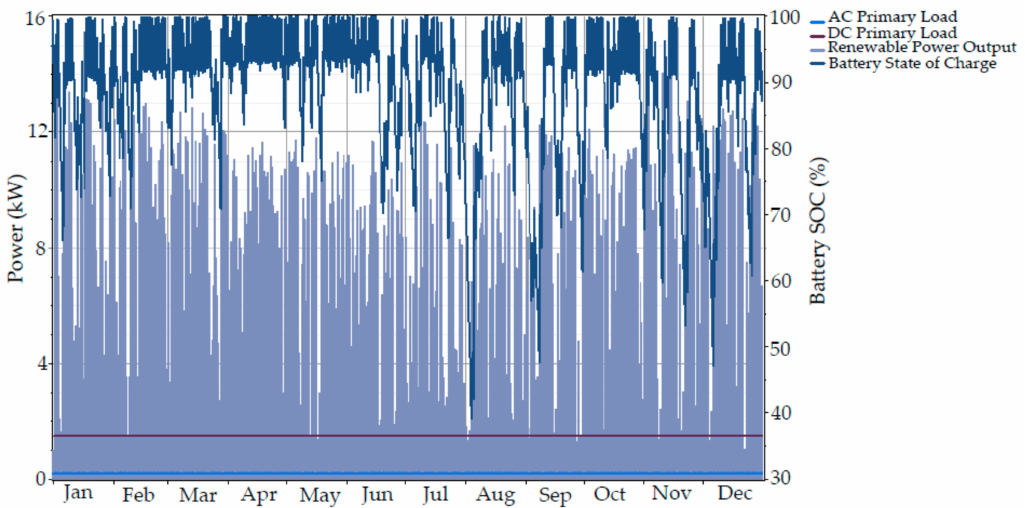
Figure 12. The average hourly power contribution of the PV array and battery bank.